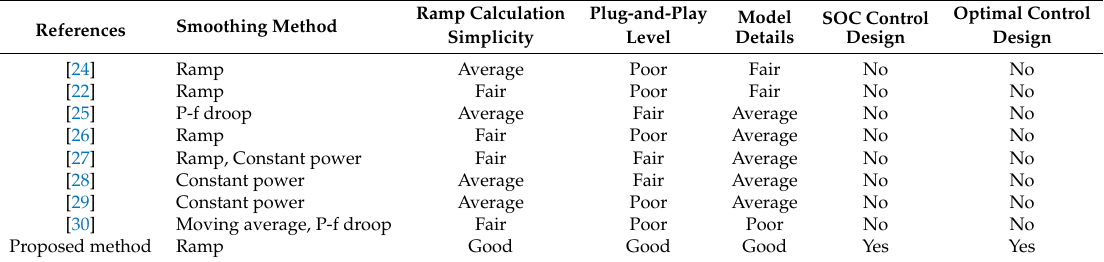
Table 7. Qualitative comparison of proposed method with existing